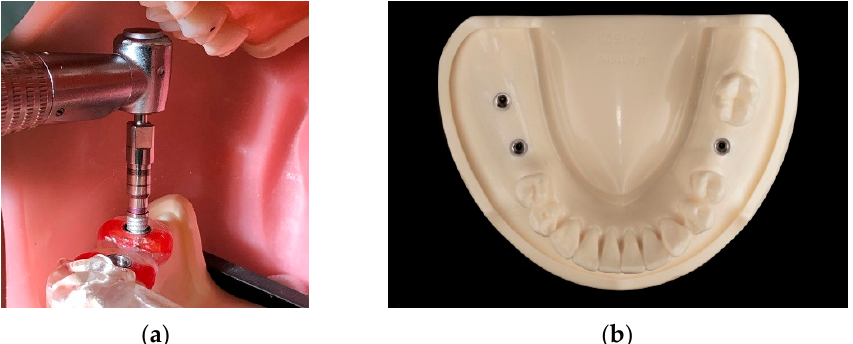
Figure 4. ( a ) Simulation implant placement performed on the model fixed to the manikin. ( b ) Three implants placed on the model.